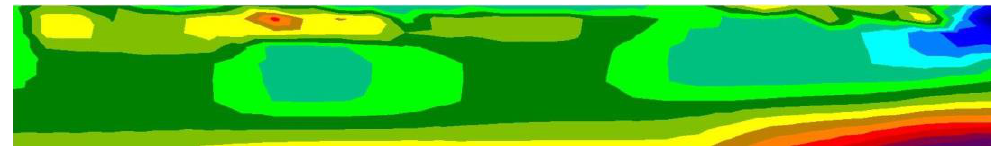
Figure 6. An example of apparent resistivity maps from Yungang Grottoes.